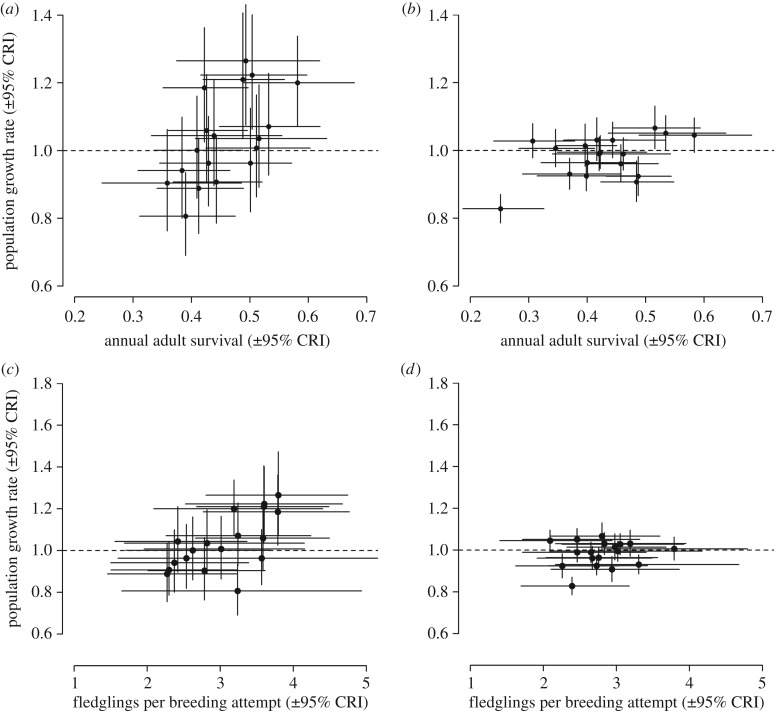
Associations between annual population growth rates and adult survival (top row) and productivity (bottom row) of willow warblers in the northwest (a,c) and the southeast (b,d) regions. See table 1 for statistical analyses.